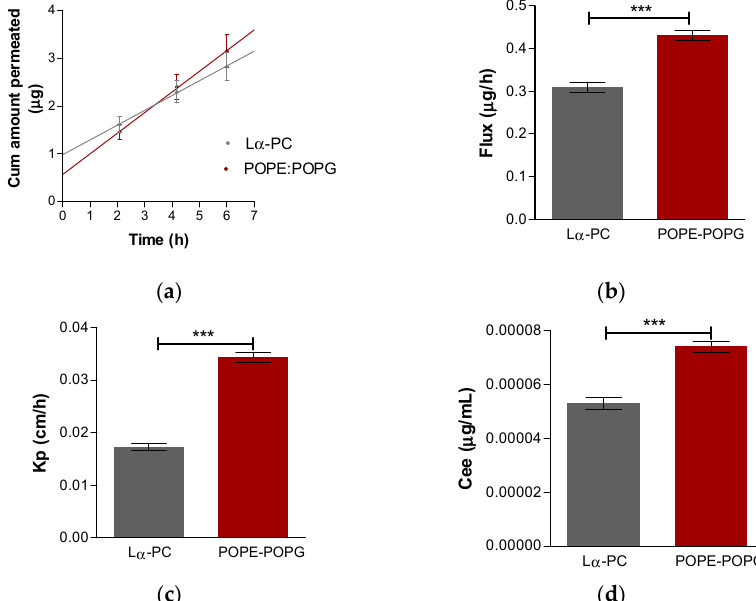
Figure 8. Ex vivo transcorneal permeation. ( a ) Baricitinib permeation profile: baricitinib cumulative amount permeated ( μ g) vs. time (h); ( b ) baricitinib flux for each liposome; ( c ) baricitinib retained amount in the cornea; ( d ) theoretical plasma concentration at the steady-state in humans. Results are expressed by mean ± SD (n = 5). L α -PC = L- α -phosphatidylcholine; POPE:POPG = 1- palmitoyl-2-oleoyl-phosphatidylethanolamine: 1-Palmitoyl-2-oleoyl-sn-glycerol-3-phosphoglycerol (3:1, mol/mol). t -Test analysis, statistically significant difference: *** = p <